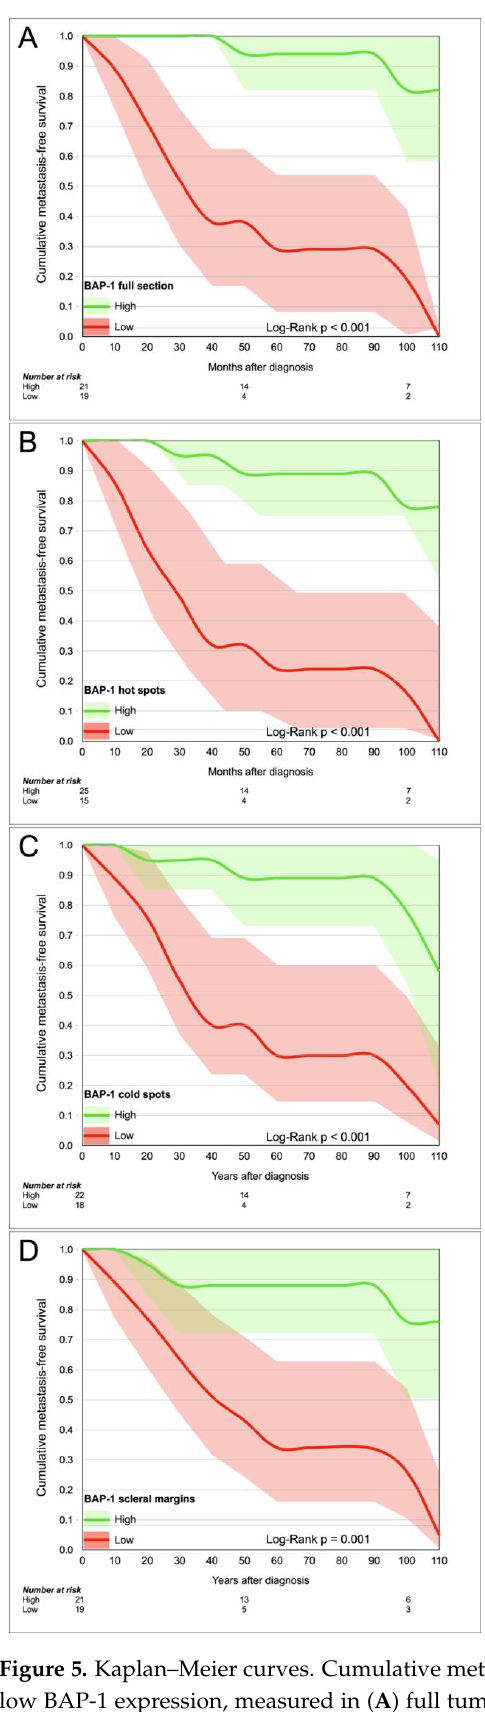
Figure 5. Kaplan–Meier curves. Cumulative metastasis-free survival for patients with high versus low BAP-1 expression, measured in ( A ) full tumor sections, ( B ) hot spots, ( C ) cold spots, and ( D ) scleral